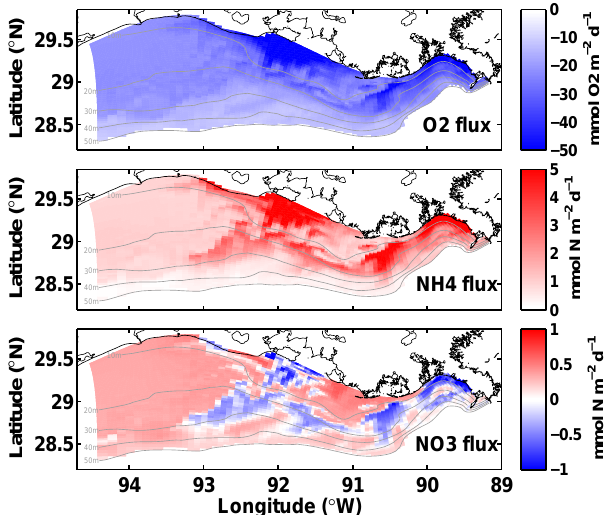
Figure 8. Spatial distribution of parameterized O 2 , NH + fluxes on 15 August 2009. Negative fluxes (blue) are into the sedi-